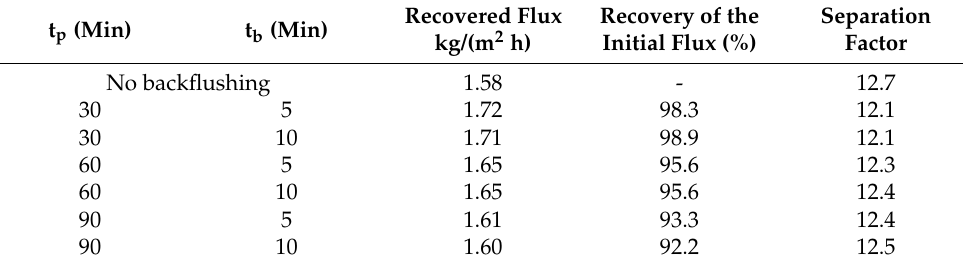
Table 4. Effect of t p and t b on the recovered flux and the separation